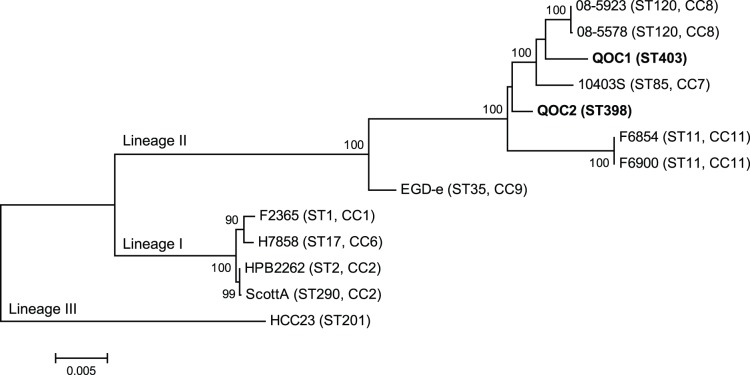
Maximum likelihood phylogenetic tree of Listeria monocytogenes strains based on MLST loci.
L. monocytogenes sequence types are indicated („ST“); „CC“ denotes clonal complexes. The tree is based on concatenated full-length MLST gene sequences and was calculated with MEGA 5 [27] using the Tamura-Nei model. Bootstrap values (500× resampling) are indicated at the respective nodes.